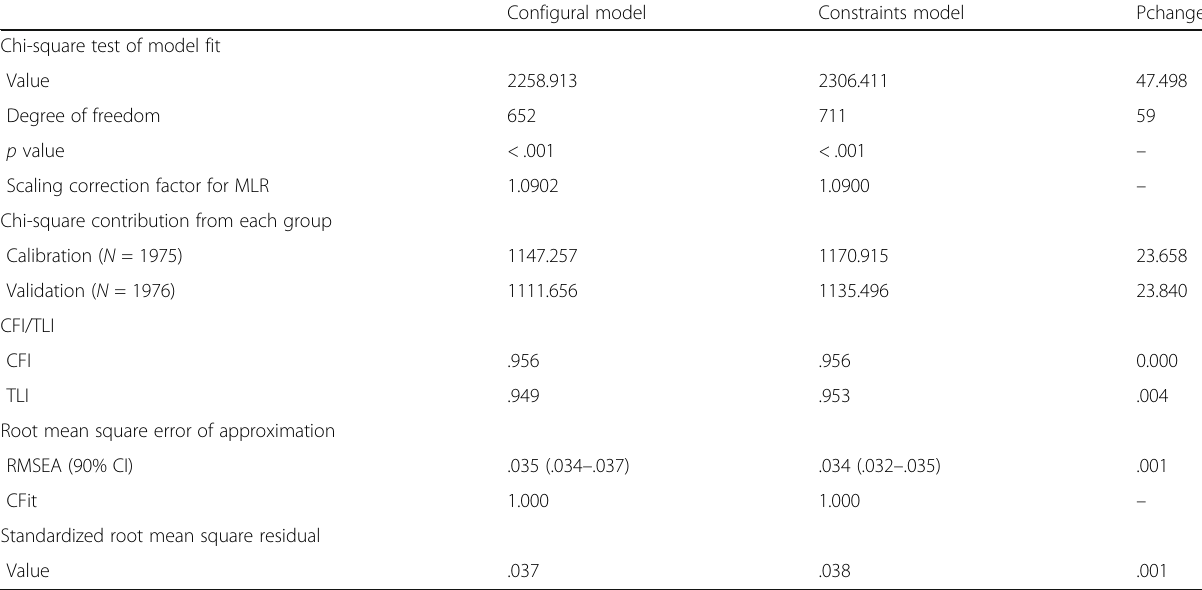
Table 3 Selected GOF indices for structural measurement invariance across two samples